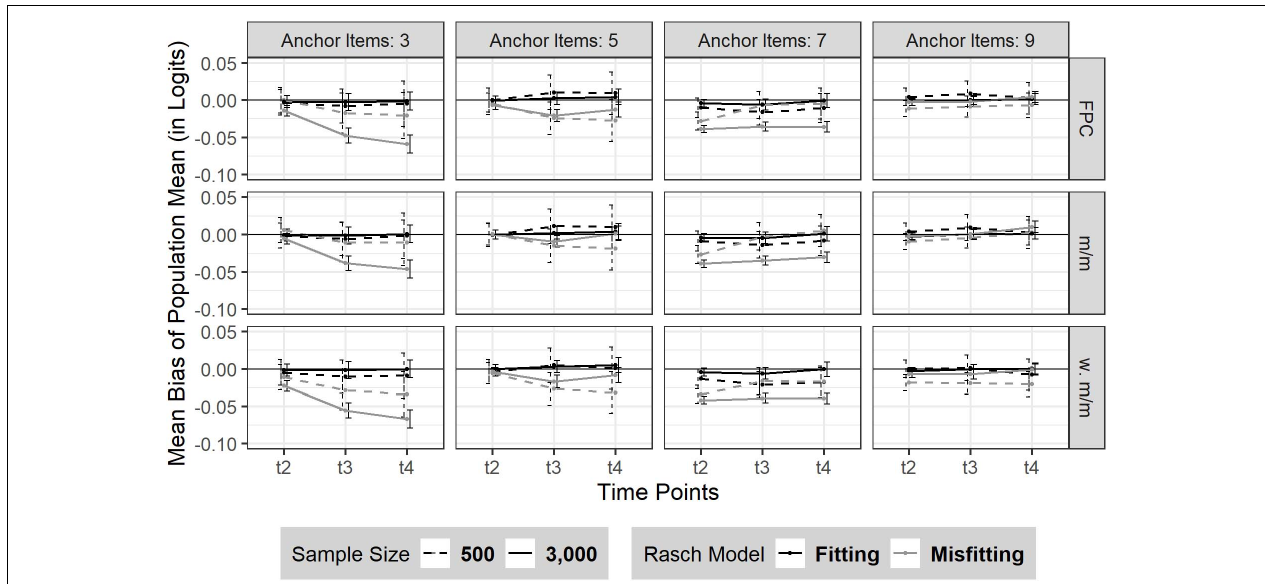
FIGURE 1 | Bias of sample mean over three time points (t 2 –t 4 ). The figure is split by three linking methods and the experimental factors number of anchor items, sample size and Rasch model-data fit. FPC = fixed parameter calibration, m/m = mean/mean linking, w. m/m = weighted mean/mean linking. 95% confidence intervals are